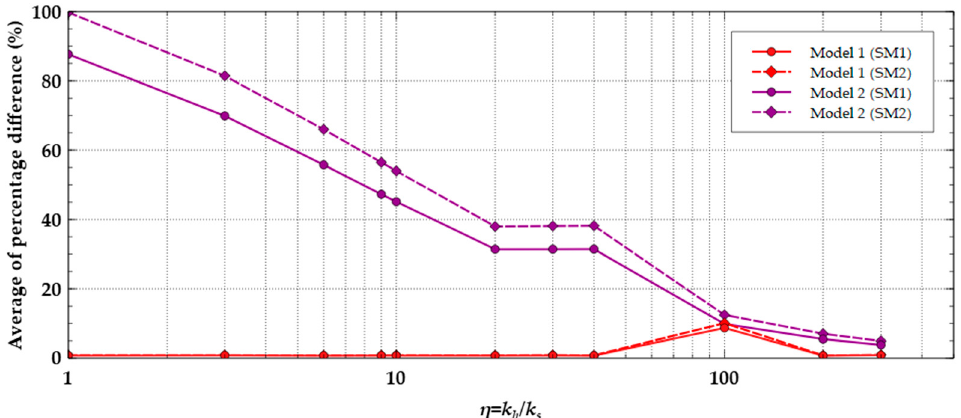
Figure 8. Model performance with the PD average .